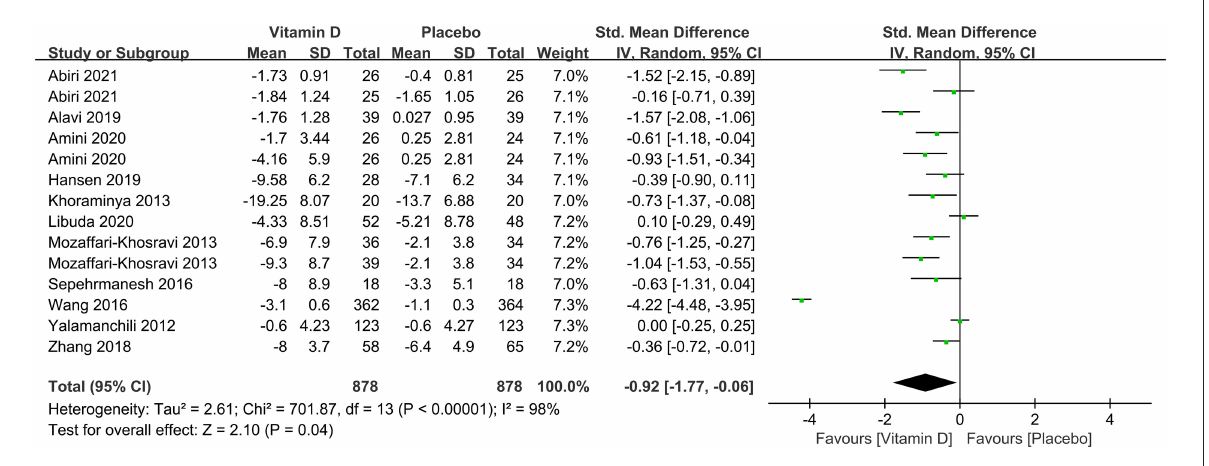
pooled effects (SMD) for low-dose analysis was − 0.30 (Figure 7A) and high-dose supplementation was − 1.23 (Figure 7B),